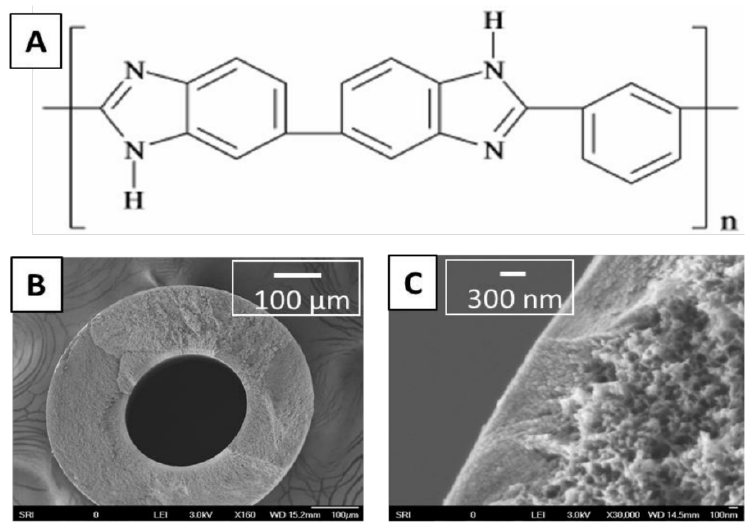
Figure 2. PBI hollow fibers. ( A ) The PBI monomer. ( B ) The SEM cross section of a single fiber. ( C ) The SEM image of the cross section near the membrane skin.